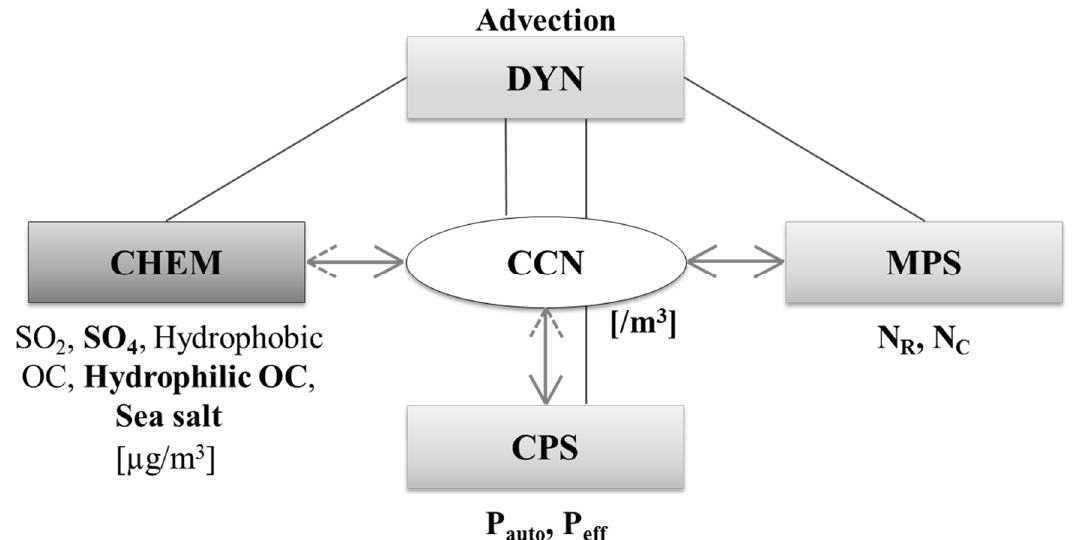
Figure 1. Relationship of the simplified chemistry package to the microphysics scheme (MPS) and the cumulus parameterization scheme (CPS). The soluble species that serve as cloud condensation nuclei (CCN) from the chemistry package are in bold. N R and N C indicate the number of rain and cloud droplets, respectively, and P auto and P eff are factors for autoconversion and precipitation efficiency.